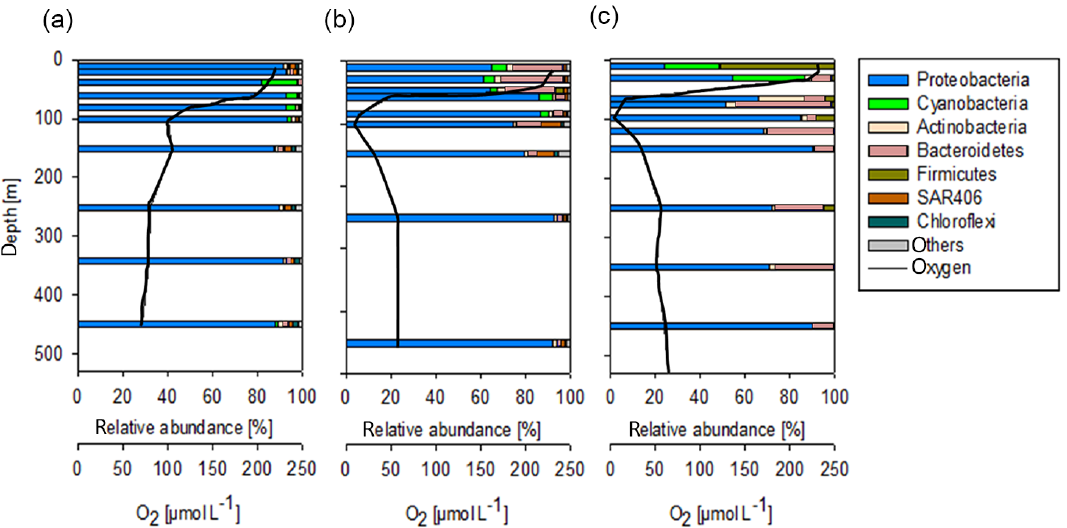
Figure 4. Distribution of bacterial phyla along vertical profiles of (a) CVOO, (b) first observation (eddy_1) and (c) second observation (eddy_2) is shown along with the O 2 gradient (black line). Data sets result from 16S rDNA amplicon sequencing (an overview on archaeal sequence distribution is given in the